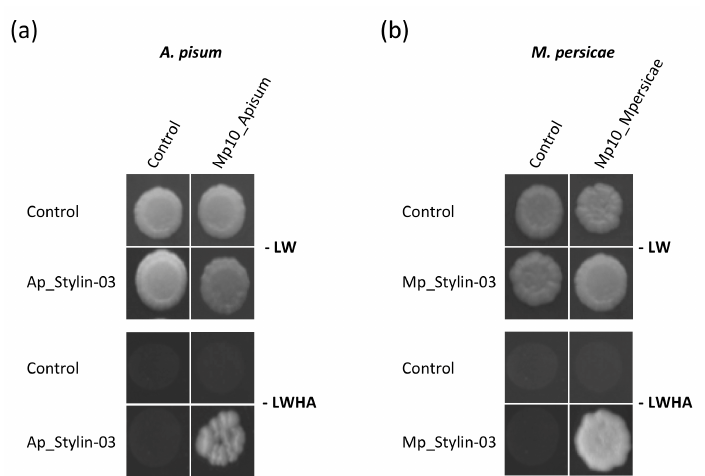
Figure 1. The cuticular protein Stylin-03 interacts specifically with the aphid effector Mp10 in yeast. NMY51 yeast strains carrying the bait vector pLexAN containing Ap_Stylin-03 (from A. pisum ) ( a ), or Mp_Stylin-03 (from M. persicae ) ( b ), were transformed with the prey vector pGADT7 containing a saliva effector of the same aphid species (Mp10_Apisum and Mp10_Mpersicae, respectively). Strains were spotted on synthetic defined (SD) non-selective medium (-LW, lacking leucine and tryptophan) and SD selective medium (-LWHA, lacking leucine, tryptophan, histidine, and adenine) and incubated at 28 °C for four days. The controls are the two plasmids pGADT7-GG-6His and